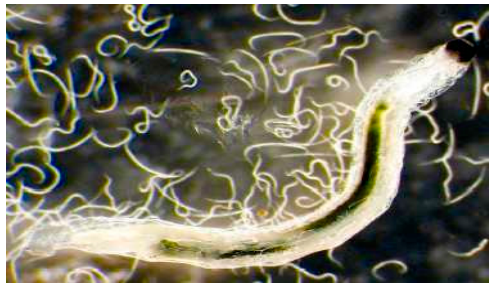
Figure 1. Sciaridae larva attacked by nematodes.